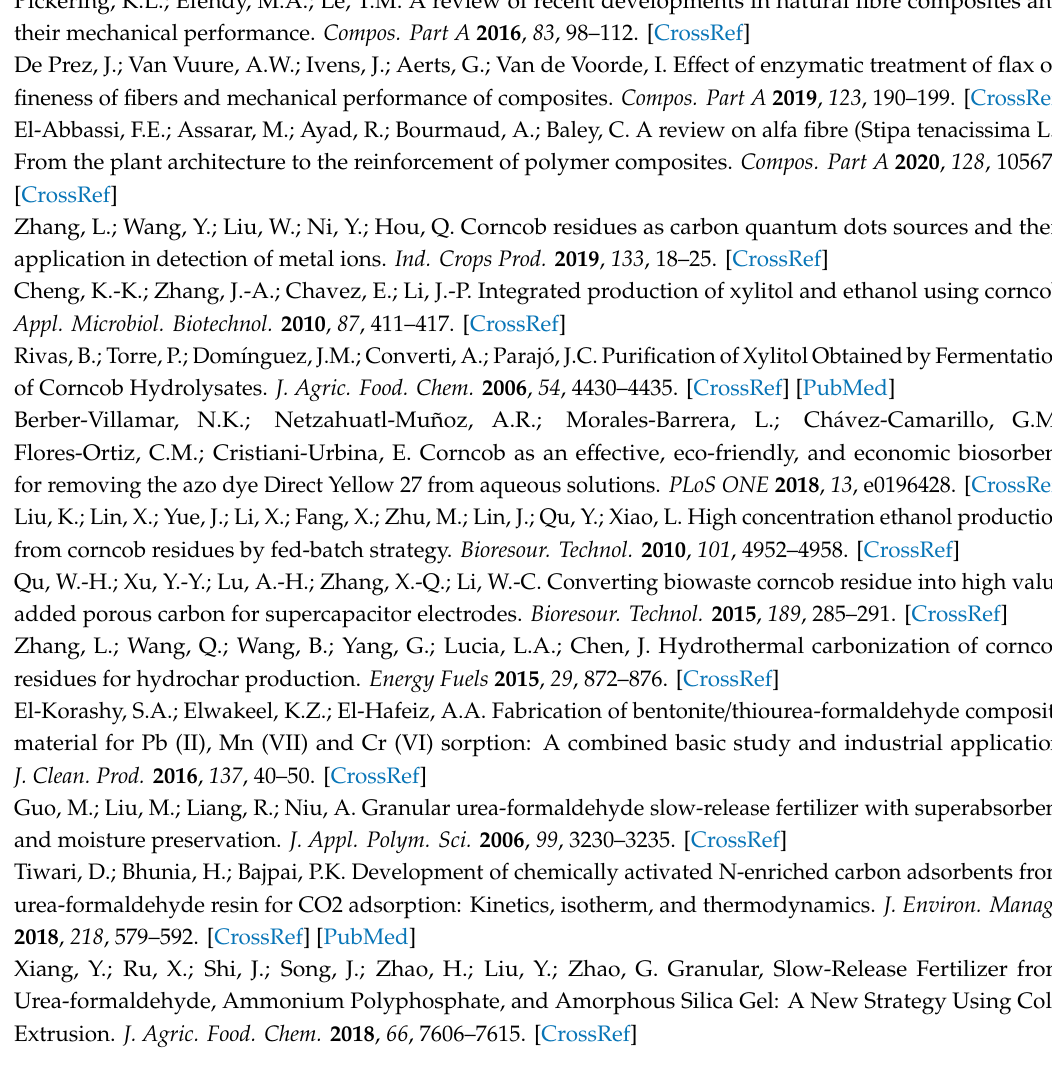
Figure S1: FTIR spectra of CR, CMCR, C, and CMC in the 4000–2600 cm − 1 region, Figure S2: Strain sweep of UF resins with flour and CMCR as fillers, Figure S3: Relationships between G’ and G” of UF resins with flour or CMCR as fillers and frequency sweep at di ff erent temperatures, Figure S4: FTIR spectra of cured UF resins with flour, CR, C, CMCR, or CMC as fillers, Figure S5: Variable temperature rheology analysis of pure UF resin, Figure S6: Fracture SEM of the pure UF resin, Table S1: Chemical compositions of corncob residues, Table S2: GPC analysis of CR, C, CMCR, and CMC, Table S3: Summary of TGA and DTG analysis, Table S4: Physical-chemical properties and plywood properties of UF resin with di ff erent